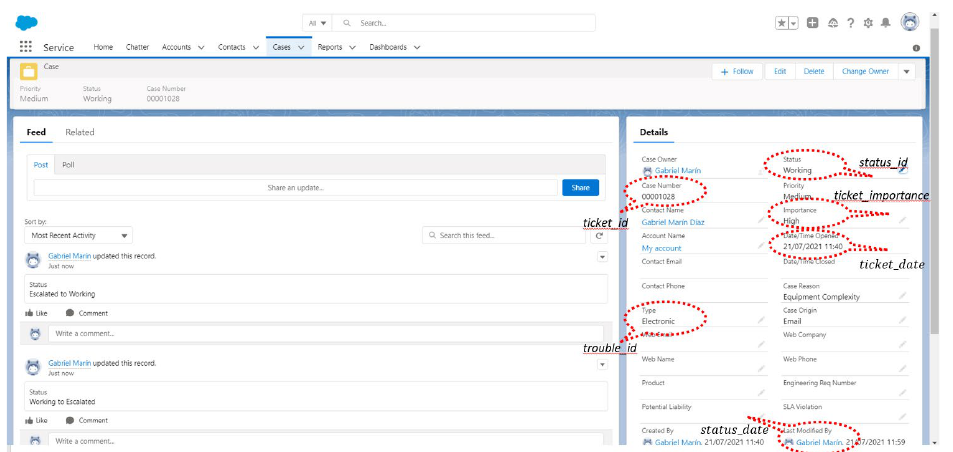
Figure 4. Salesforce Case New.